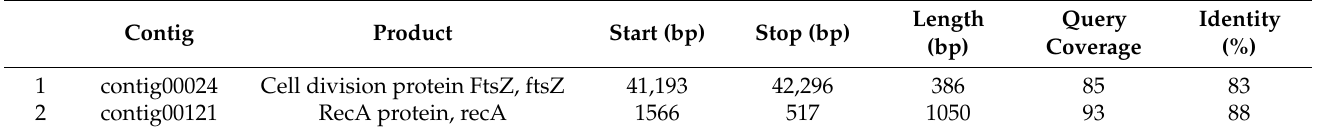
Table A9. Dactylosporangium sp. AC04546 drug target gene identified using PATRIC server, verified using DrugBank server.